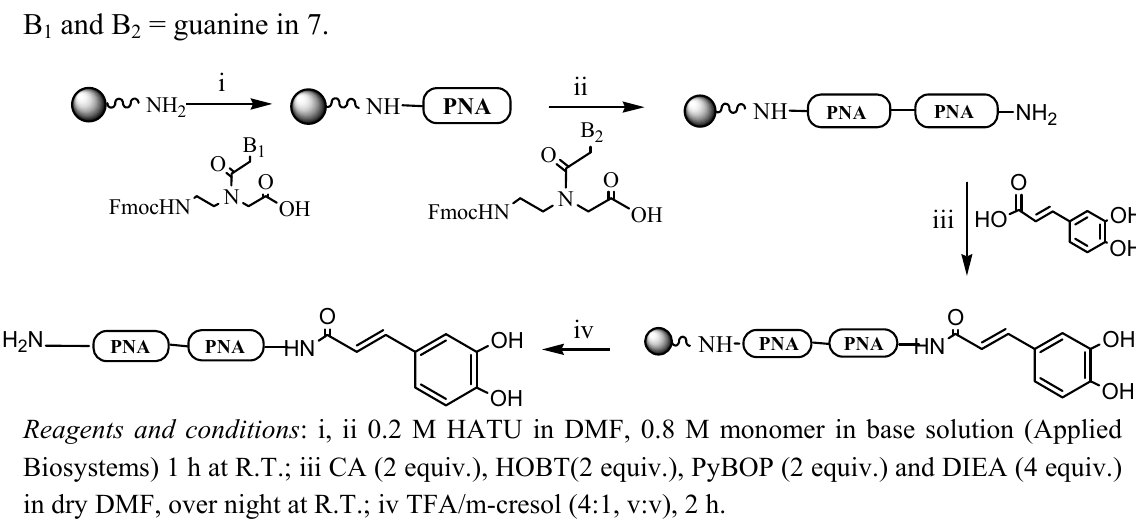
= guanine and B 1 = cytosine in 3 B 2 = thymine and B 1